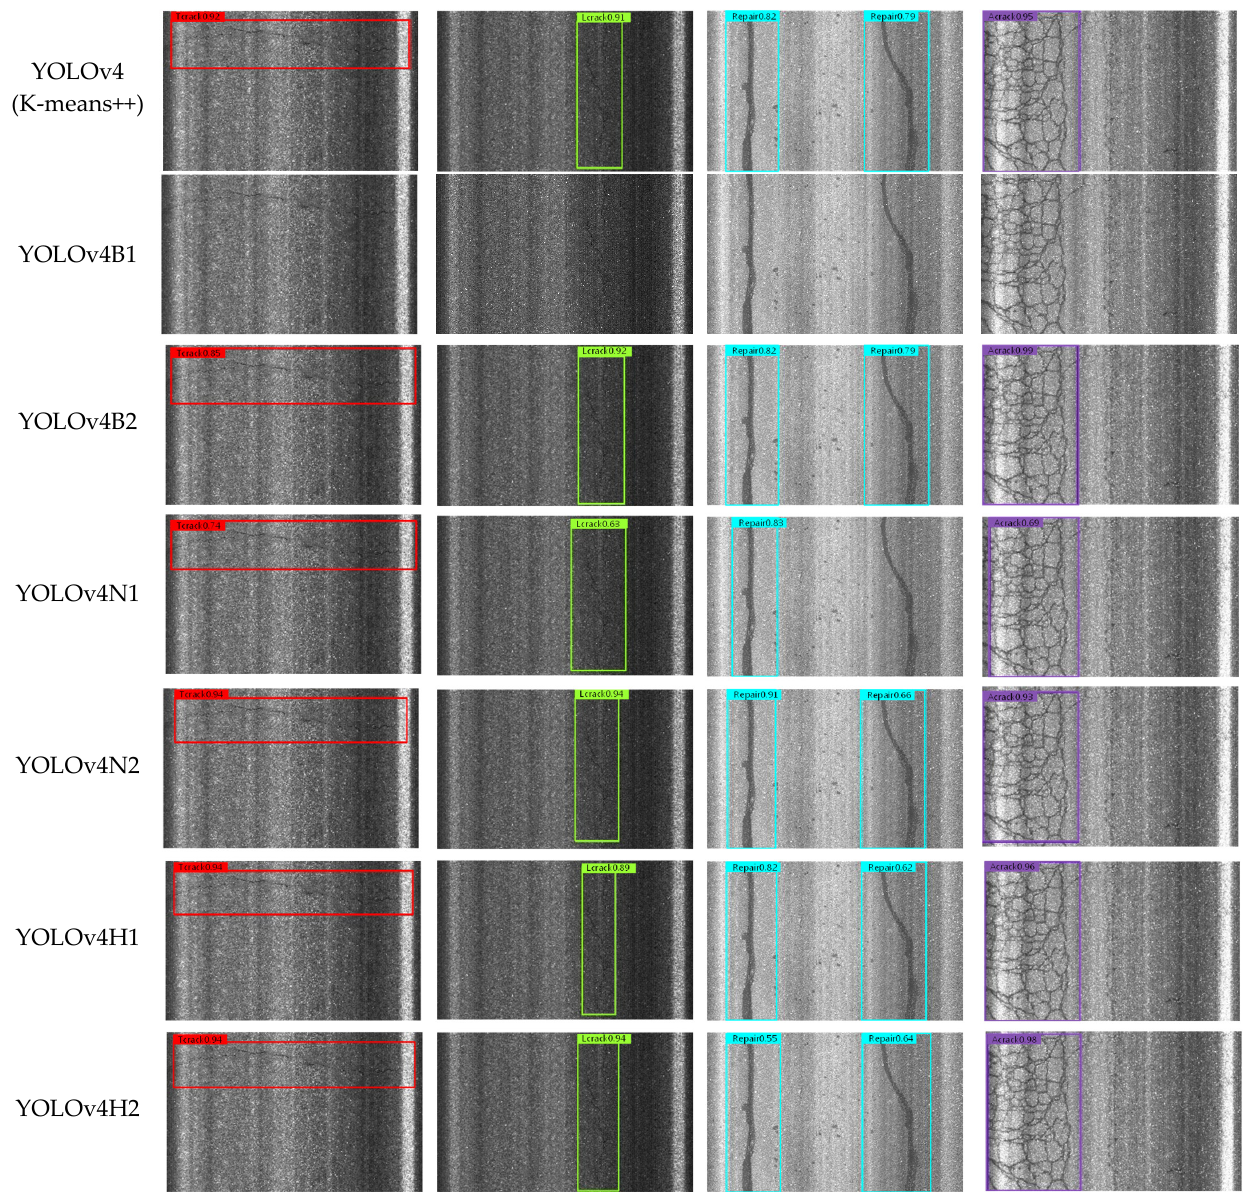
Figure 10. The detection effect of six models with different attention modules.